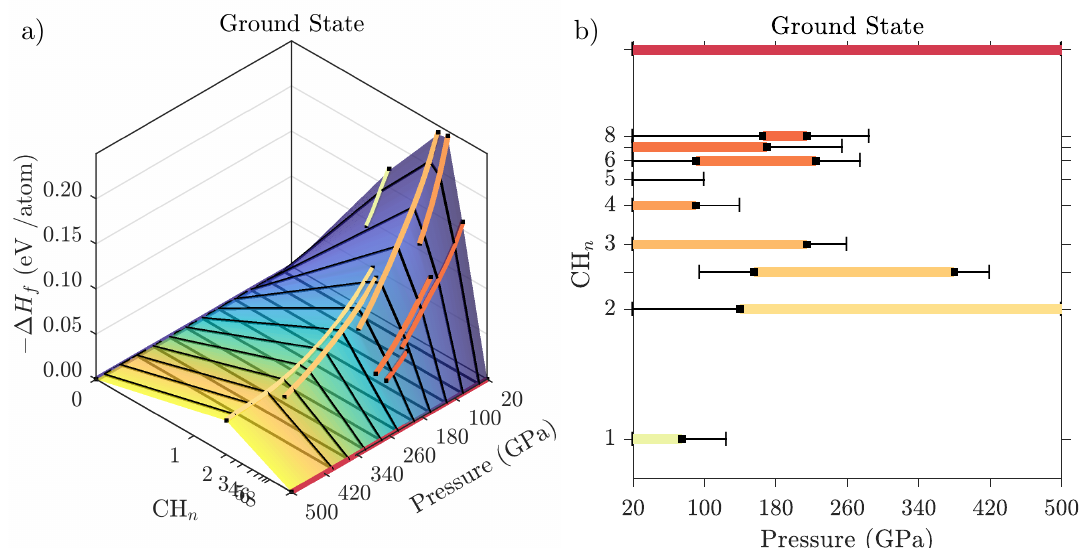
Figure 6. ( a ) Convex hulls for C-H compounds at high pressure from ground state PBE calculation, showing formation enthalpies ∆ H f as function of hydrocarbon composition and for a series of pressures (black lines). Phases on the convex hull are indicated by thick coloured lines. ( b ) Resulting hydrocarbon phase diagram as function of pressure and composition. Metastable phases (that are within 5 meV of the convex hull) are indicated by thin black